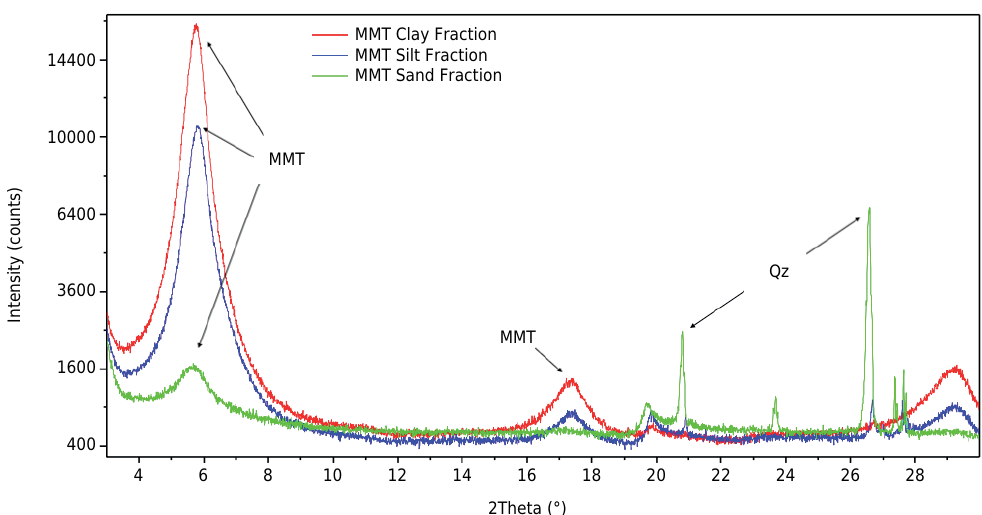
Figure 3. XRD of sand, silt, and clay fractions of the montmorillonite sample.